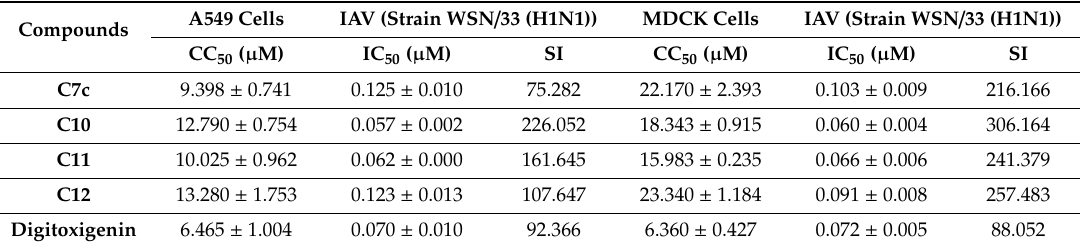
Table 1. Cytotoxicity and antiviral activity of compounds C7c , C10 , C11 , C12 , and digitoxigenin against influenza A virus (strain WSN / 33 (H1N1)) replication on A549 and MDCK cells. Compounds